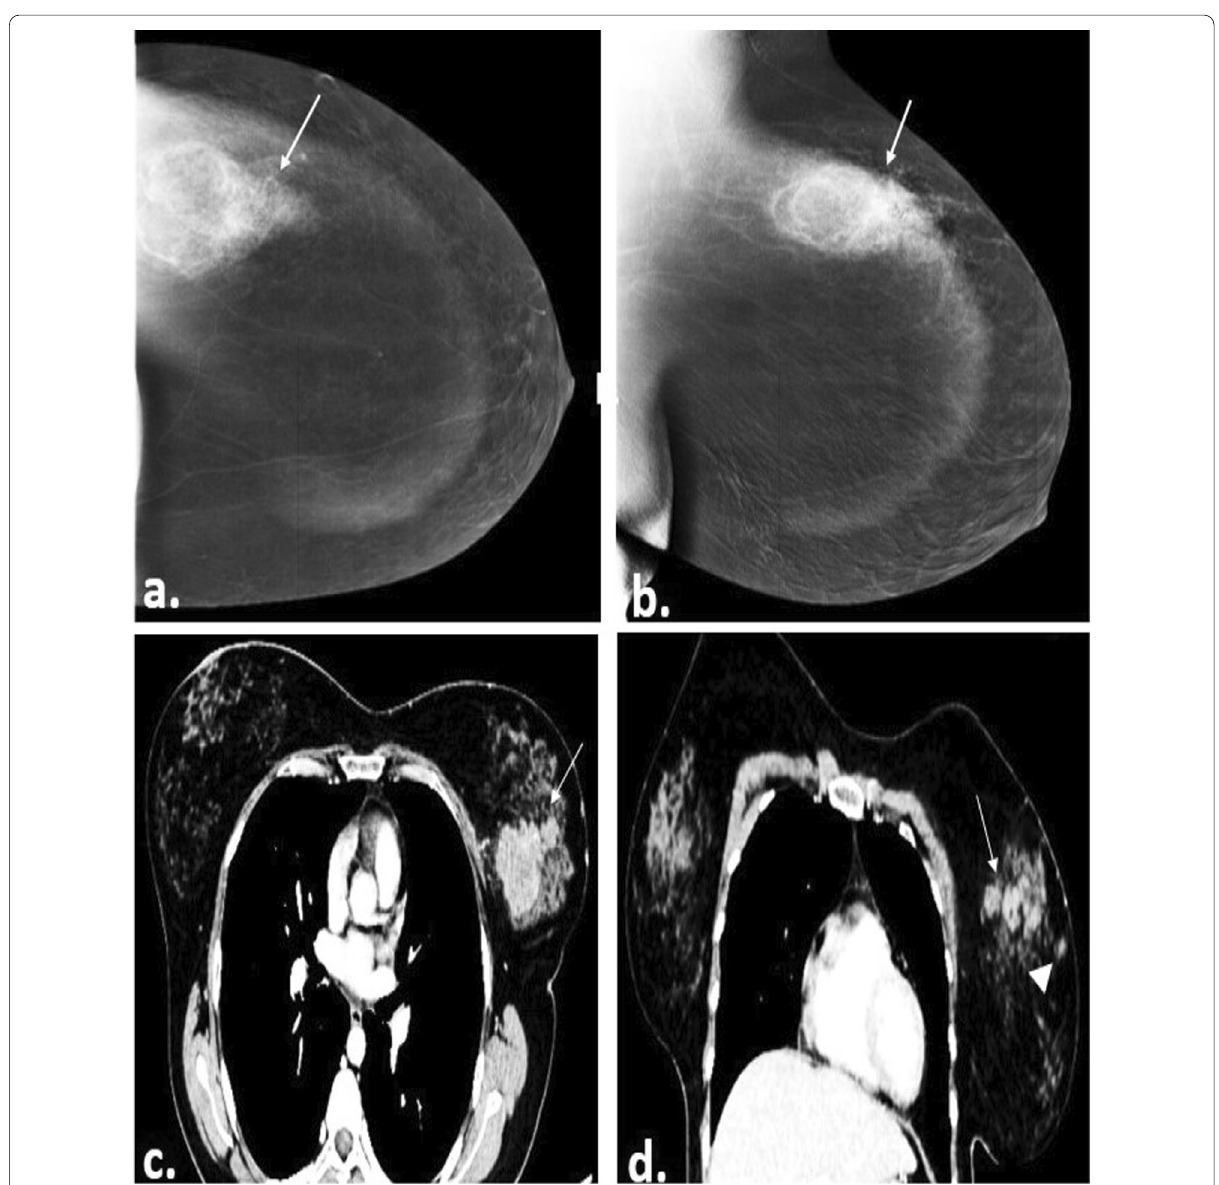
Fig. 2 A 46‑year‑old female patient with positive family history complained of a left breast lump. CESM of left breast CC and MLO views ( a , b ) showed left UOQ single heterogeneously enhancing mass lesion. Contrast‑enhanced chest CT axial and coronal images ( c , d ) showed left breast UOQ intensely enhancing mass lesion (arrow) along with another anteriorly located small enhancing nodule (arrowhead) representing multifocal disease. The histopathology result was IDC with tubular differentiation, grade